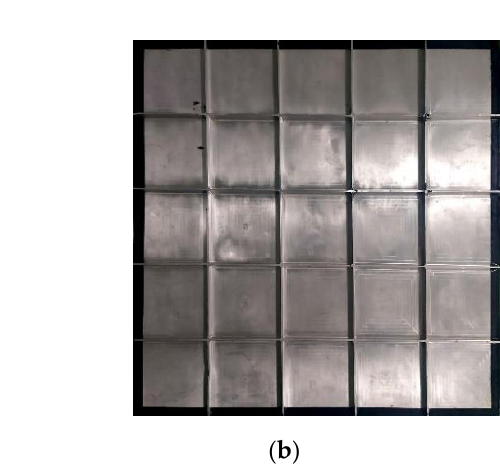
Figure 4. Actual structure diagrams of the test plate: ( a ) front side; ( b ) reverse side.